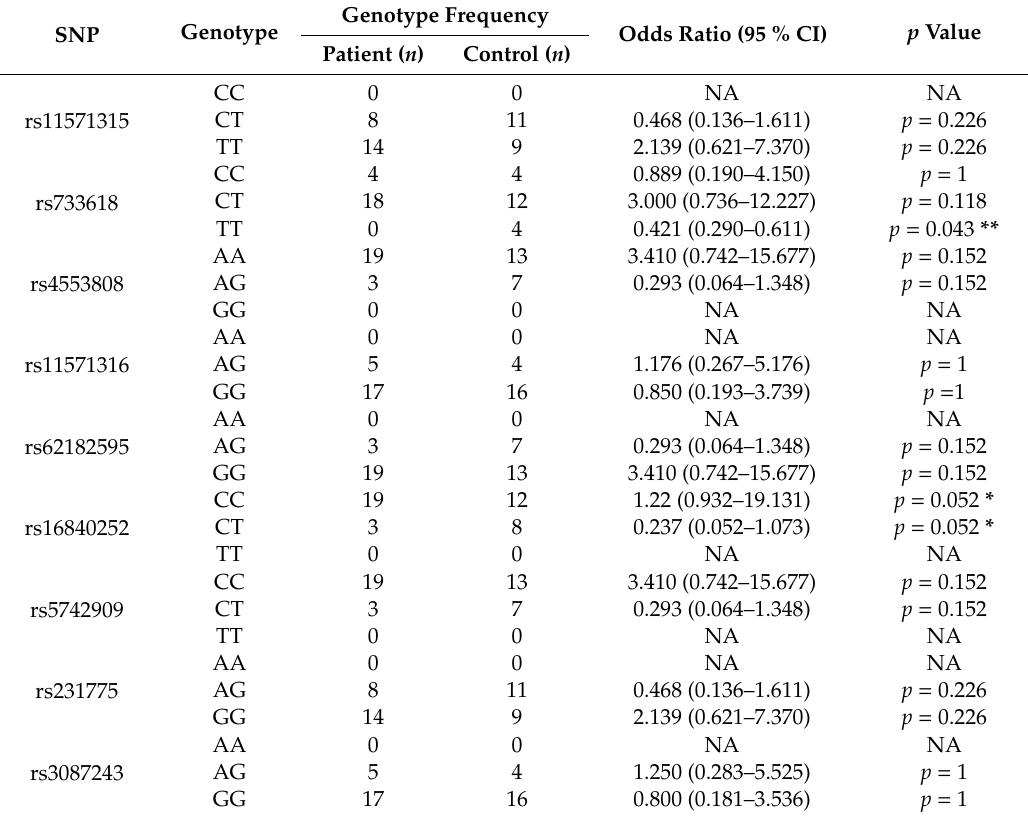
Table 4. Statistical analysis of CTLA4